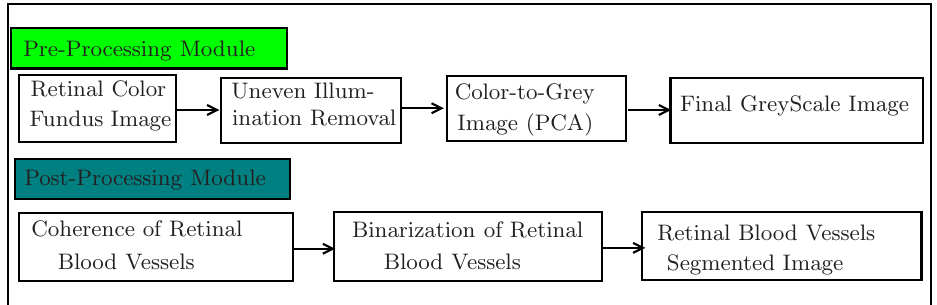
Figure 3. Our Proposed